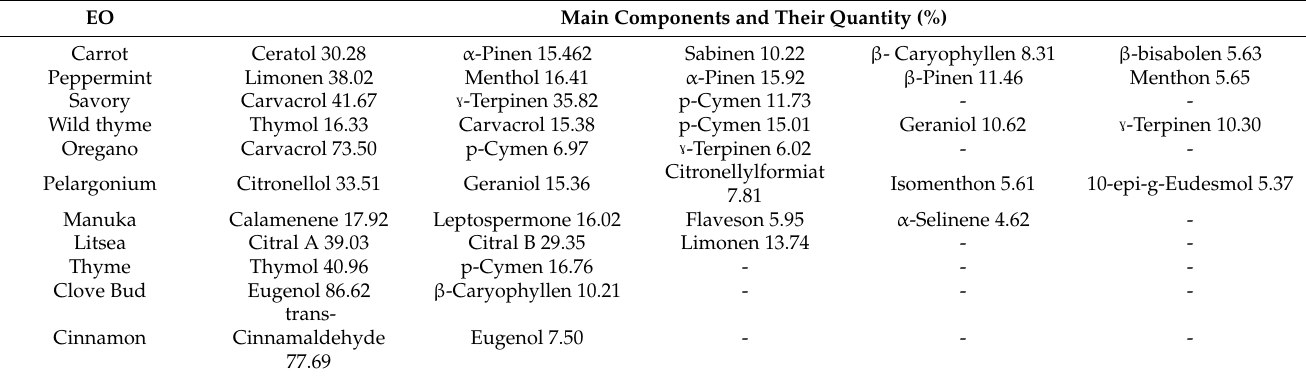
Table 3. Composition of the most effective essential oils and their constituents’ quantity (>5%).